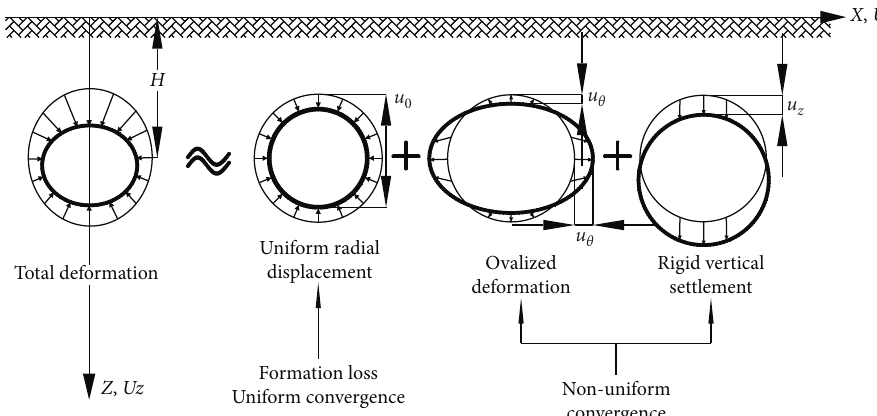
0 denotes the uniform radial displacement; u θ denotes the ovalized